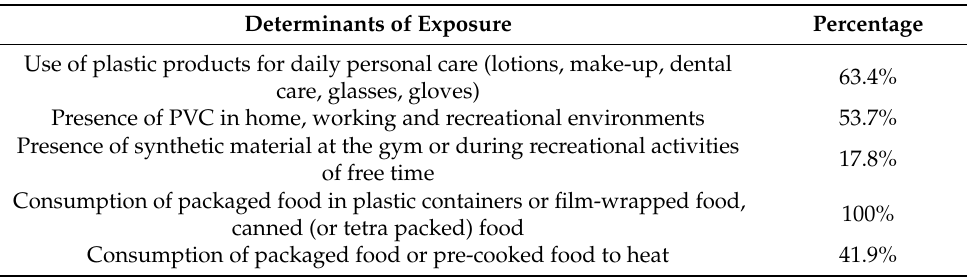
Table 1. Phthalate and BPA exposure determinants. Phthalate and BPA determinants of exposure were explored through a structured telephone interview extrapolating questions from the LIFE PERSUADED (“Phthalates and bisphenol A biomonitoring in Italian mother–child pairs: link between exposure and juvenile diseases”) Project questionnaire [37]. Data are presented as the frequency of subjects reporting the lifestyle habits listed in the table and expressed as